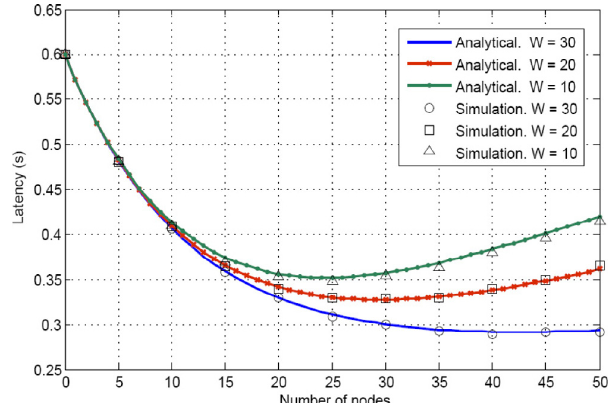
Figure 10. Latency of the IPAA protocol as a function of network size with contention window size as a